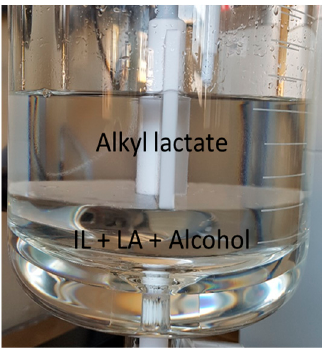
Scheme 4. Photograph of the reactor with the postreaction mixture of model esterification of lactic acid with 2-ethylhexanol (IL—ionic liquid).